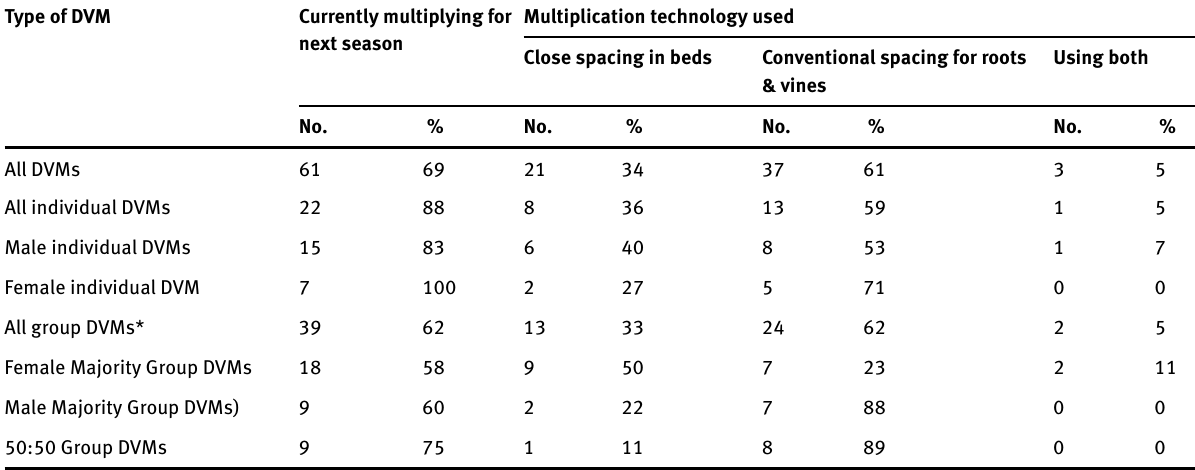
Table 1: Multiplication status and use of multiplication technology nine months after intervention closed (March 2013) Type of